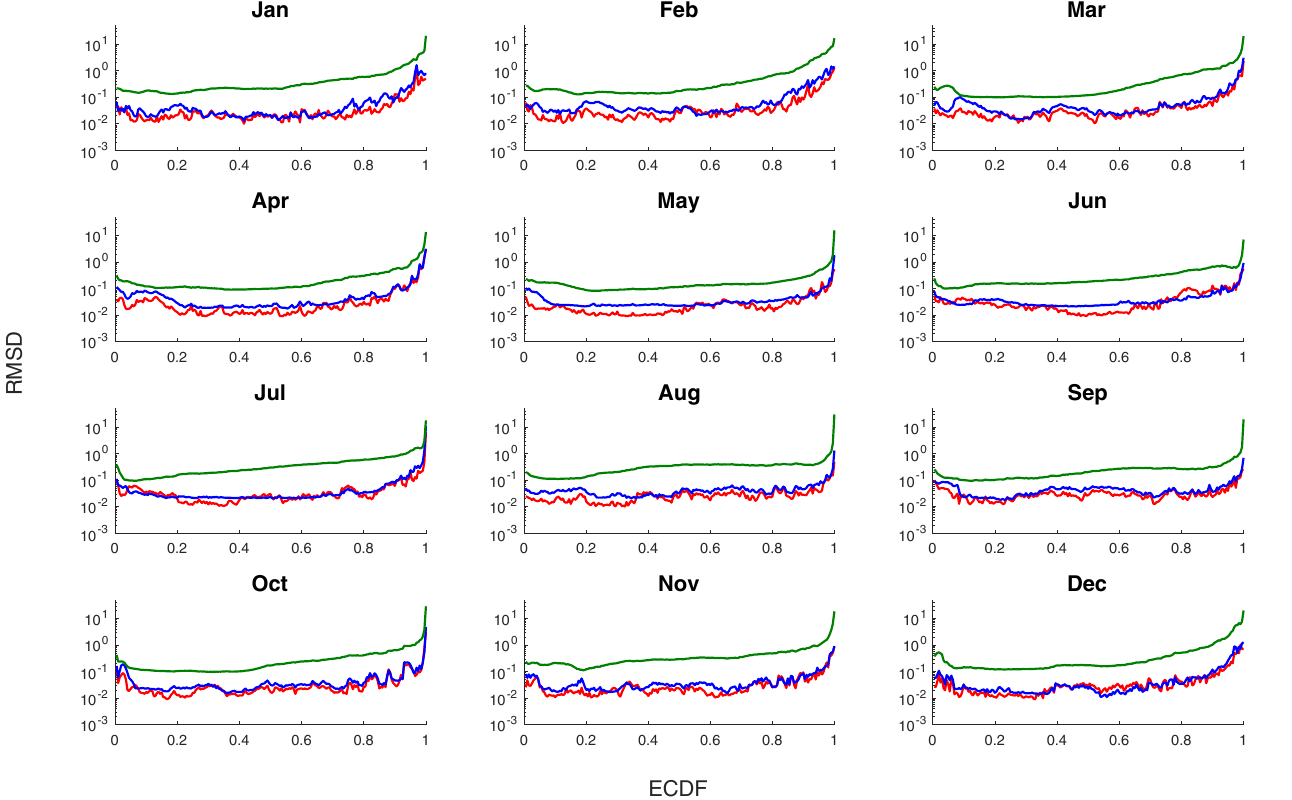
Figure 18. Root mean square difference (RMSD) for simulated discharge in different cases: case 1 (red), case 2 (blue) and case 3 (green). The RMSD is plotted against the cumulative relative frequency of the discharge given by the empirical cumulative distribution (ECDF) value.